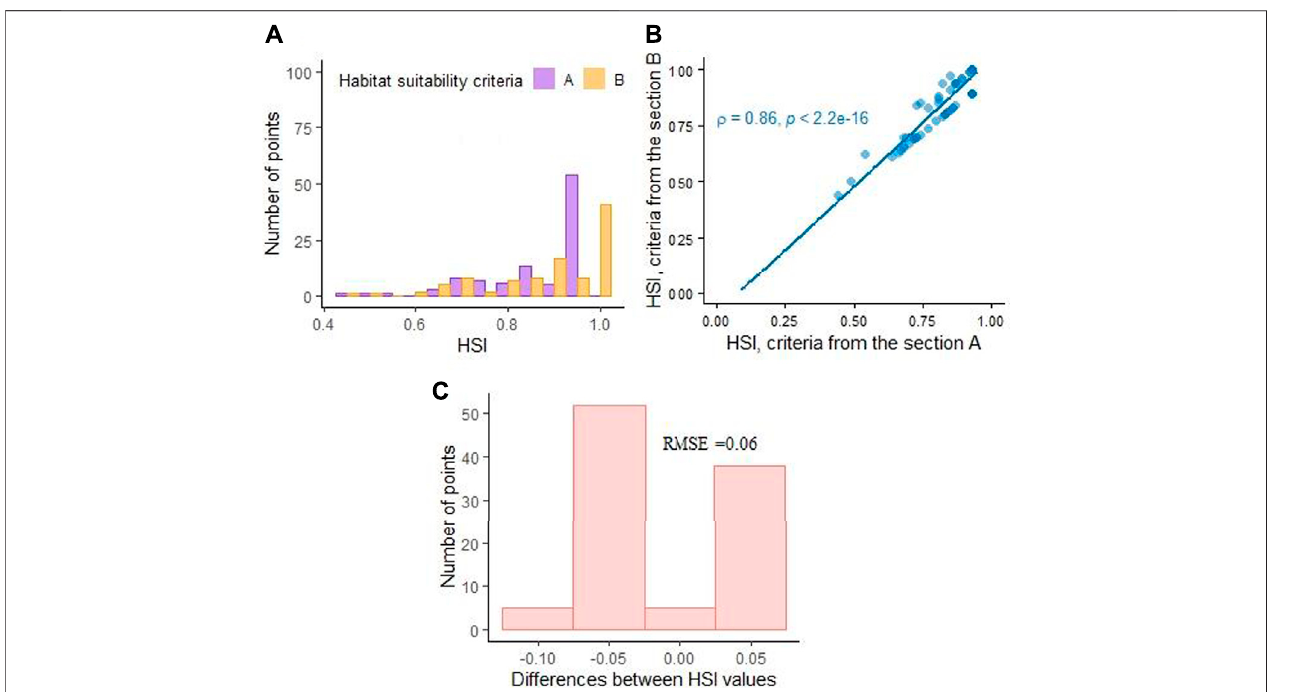
FIGURE 3 | Comparison of HSI values. (A) – histogram of HSI values; (B) – relationship between HSI values for criteria from section A and B; (C) – histogram of differences between HSI values.